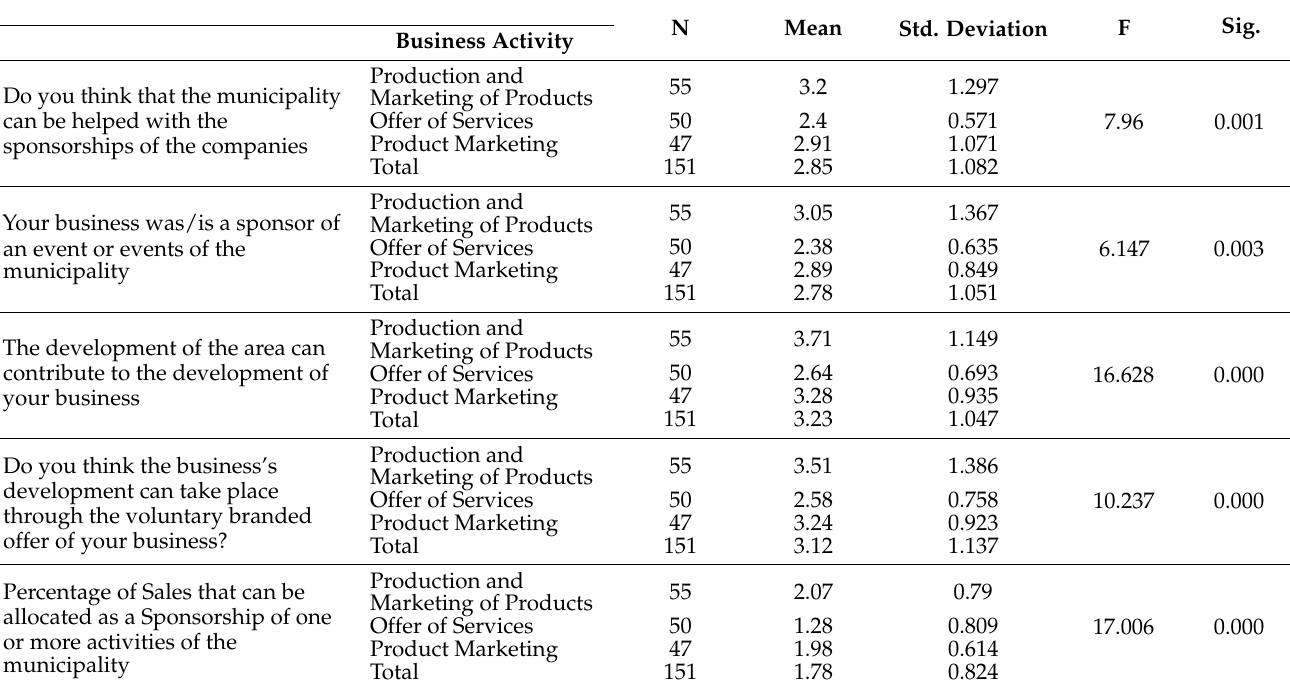
Table 2. One-Way Analysis of Variance (ANOVA) with Criterion of the Business Activity. N Mean Std. Deviation